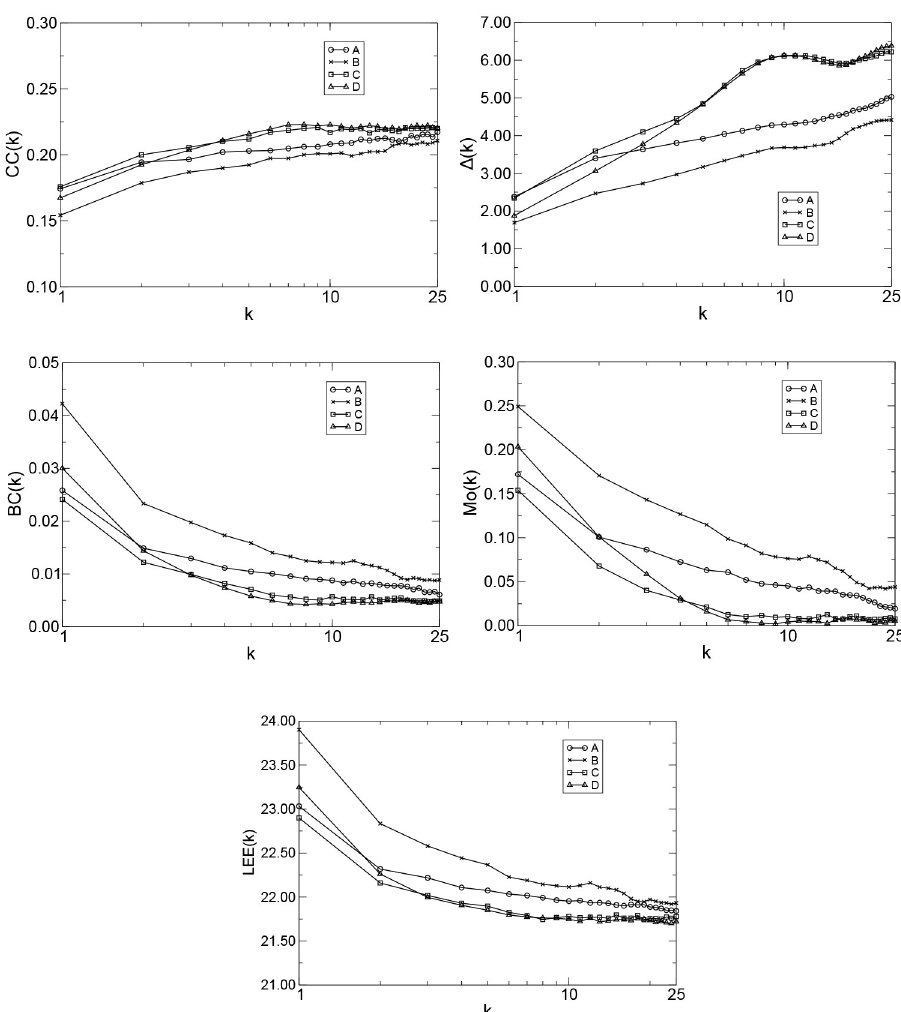
Fig 3. CC ( k ), Δ ( k ), BC ( k ), Mo ( k ), and LEE ( k ) versus k , T = 1, 024, Q = 20, and k = 1, 2, ... , 25 for the groups A (patients from health controls, eyes open), B (patients from health controls, eyes closed), C (patients with AD, eyes open), and D (patients with AD, eyes